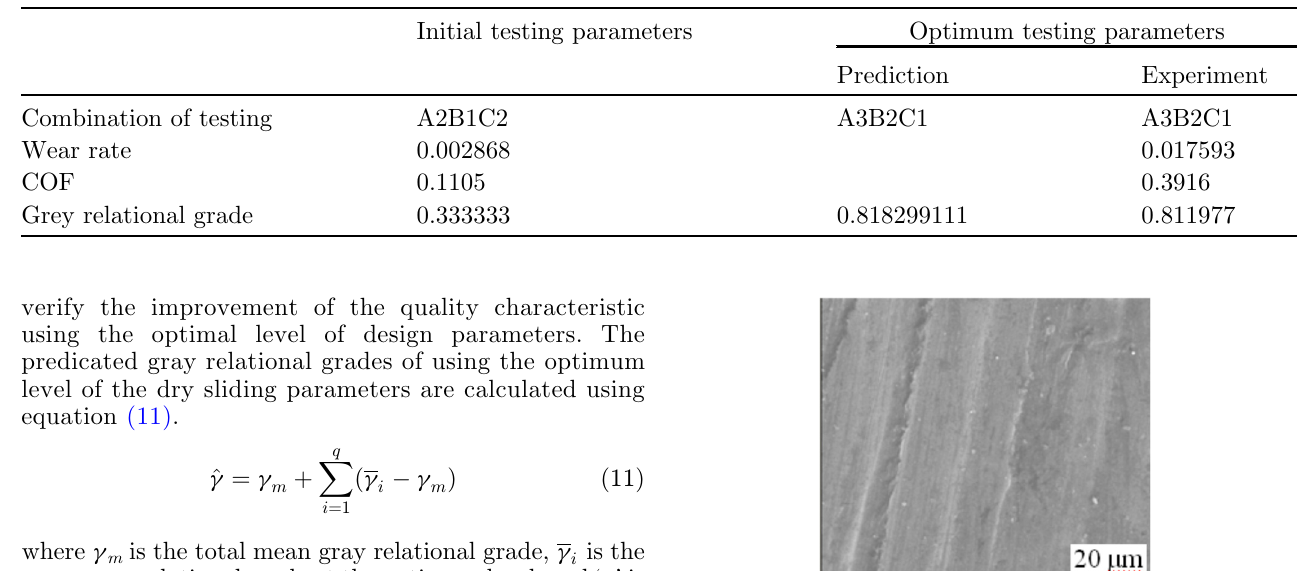
Table 8. Results of con fi rmation experiments.